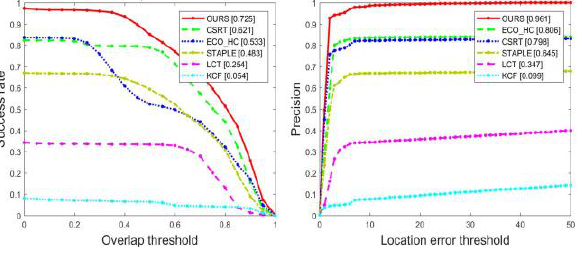
Figure 2 Three data sets in the experiment. Traffic scenes in the USA, Mexico and Spain are shown respectively. The planes are selected as the targets in A and B, while the car is chosen as the target in